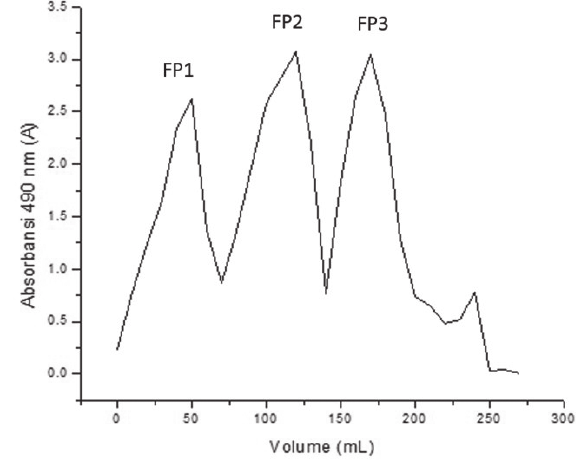
Figure 2. Analysis of the purified fractions of C. lentillifera on DEAE Sepharose. Noted: FP 1 fraction 1; FP 2 fraction 2; FP 3 fraction